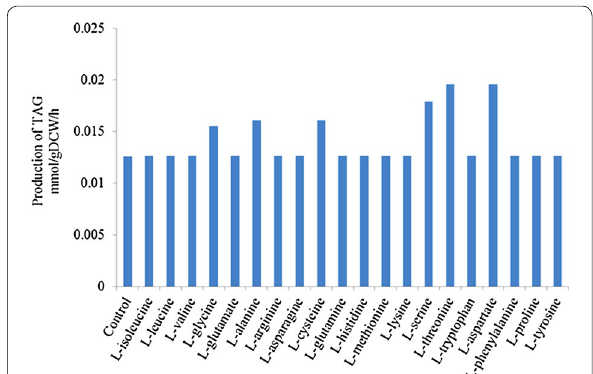
Fig. 4 Simulation effects of amino acid supplementation on TAG production in Y. lipolytica grown in MG